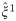
Phase portraits corresponding to critical transitions in Scenario 1 and Scenario 2.These phase portraits occur for a special value of σ such that ξ^1 changes from a saddle to a sink. (a) The phase portrait of the critical transition corresponding to Scenario 1 contains a sequence of connecting trajectories from ξ1 to ξ2, allowing for a transition from ξ1 to ξ2 with arbitrarily small noise (e.g. for ρ = 2.4, τr = 900, λ = 0.55, μ = 0.45, the critical transition occurs at s1 ≈ 0.45, s2 ≈ 0.56). (b) In the phase portrait of the critical transition corresponding to Scenario 2, a transition from ξ1 to ξ2 would fail unless the noise amplitude is sufficiently large. (e.g. for ρ = 2.4, τr = 900, λ = 0.55, μ = 0.15, the critical transition occurs at s1 ≈ 0.37, s2 ≈ 0.49).